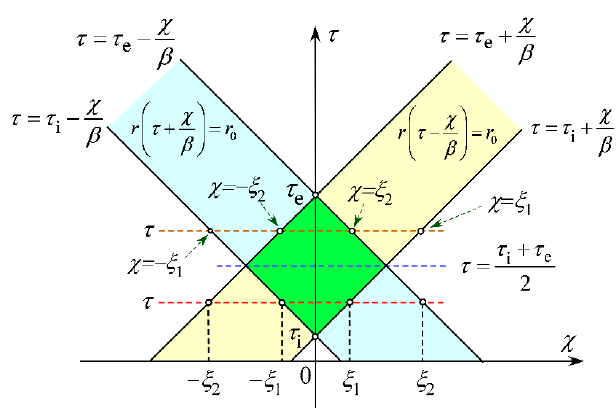
Figure A1. Domains of integration highlighted in yellow and light blue where the conditions of r ( τ − χ / β ) = r 0 and r ( τ + χ / β ) = r 0 are satisfied, respectively. ξ 1 = β ( τ − τ i ) and ξ 2 = β ( τ e − τ ). Their overlapping domain is shaded in green. β is the sweep rate of the angular frequency of the employed tunable laser output, τ i and τ e are round trip times from the origin at τ = 0 to the input and output ends of the fiber under test, respectively.